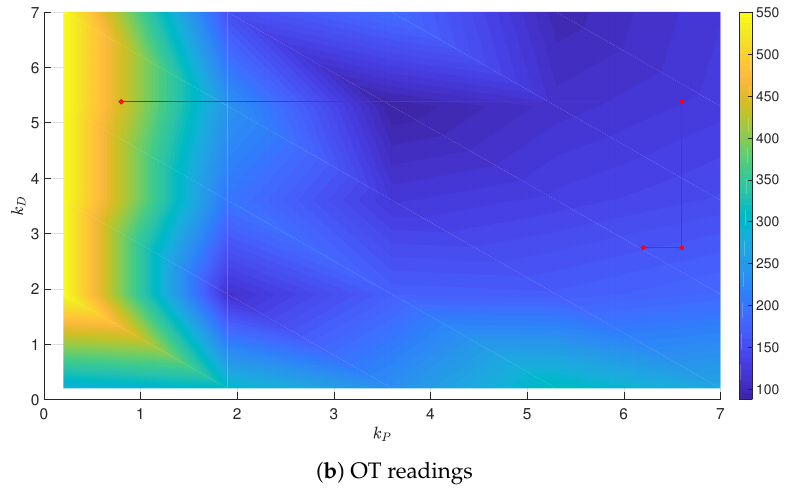
Figure 12. Velocity-penalized trajectory surface with partial results of tuning.